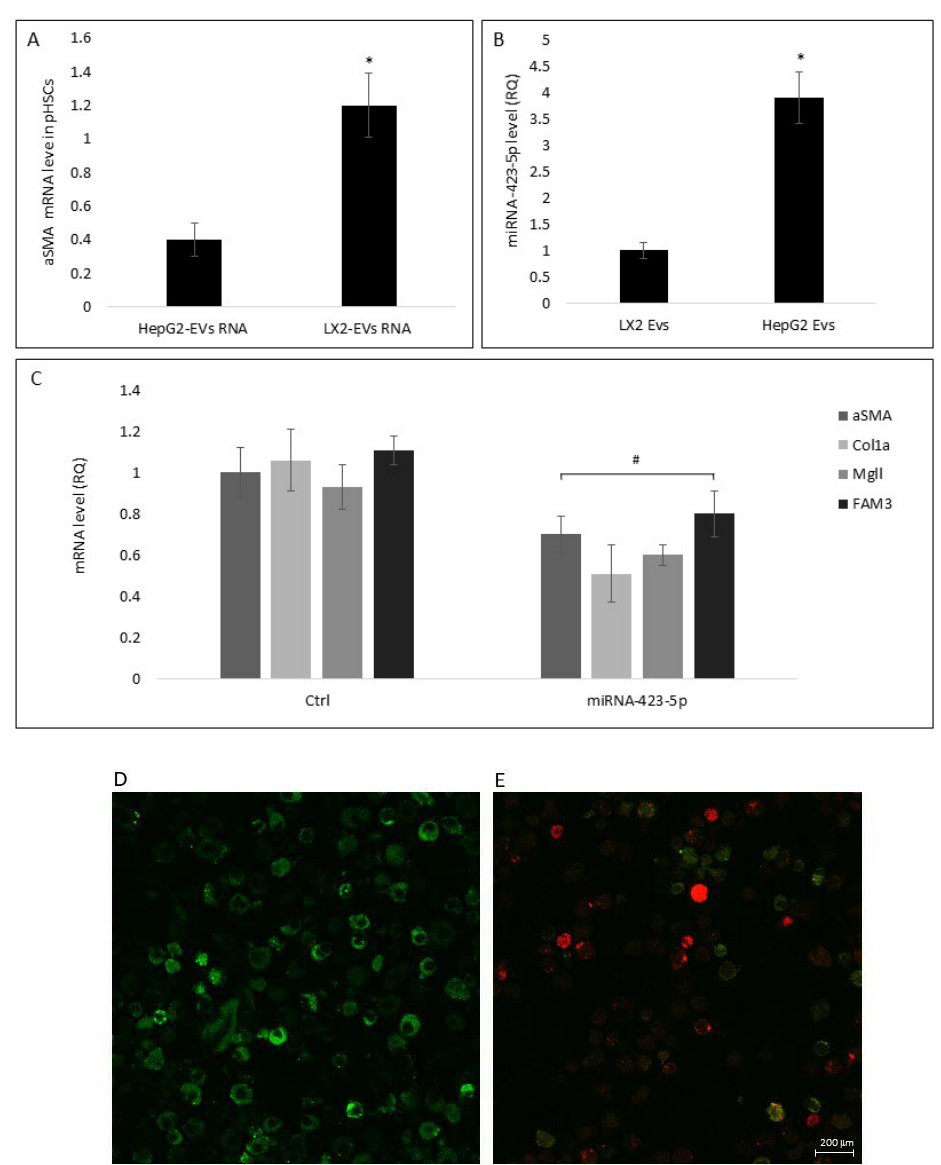
Figure 7. The effect of miRNA purified from HepG2-EVs, LX2-EVs, or miR-423-5p mimic on pHSC differentiation markers. miRNA sequences purified from HepG2-EVs or LX2-EVs were transfected into pHSCs. Following transfection (24 h), pHSCs were harvested and αSMA mRNA levels were determined. ( A ) The effect of miRNA purified from HepG2-EVs and LX2- EVs on αSMA mRNA levels in pHSCs. ( B ) miR-423-5p levels in LX2 and HepG2 EVs. RNU6 was used as a reference gene. ( C ) pHSCs were transfected with either 20 pM miR-423-5p mimic or non-relevant miRNA sequences as a control) . Following transfection (24 h), pHSCs were harvested and αSMA, Col1a, Mgll , and FAM3 mRNA levels were determined using RT-PCR. ( D ). Labeled pHSCs (green) ( E ). Merge image of labeled pHSCs (green) with labeled microRNA (red). Results are expressed as mean ± SEM of three independent experiments. * Significantly lower than LX2-EVs; # Significantly lower than Ctrl, p < 0.05 (ANOVA with a post-hoc Bonferroni-adjusted Student’s t -test).